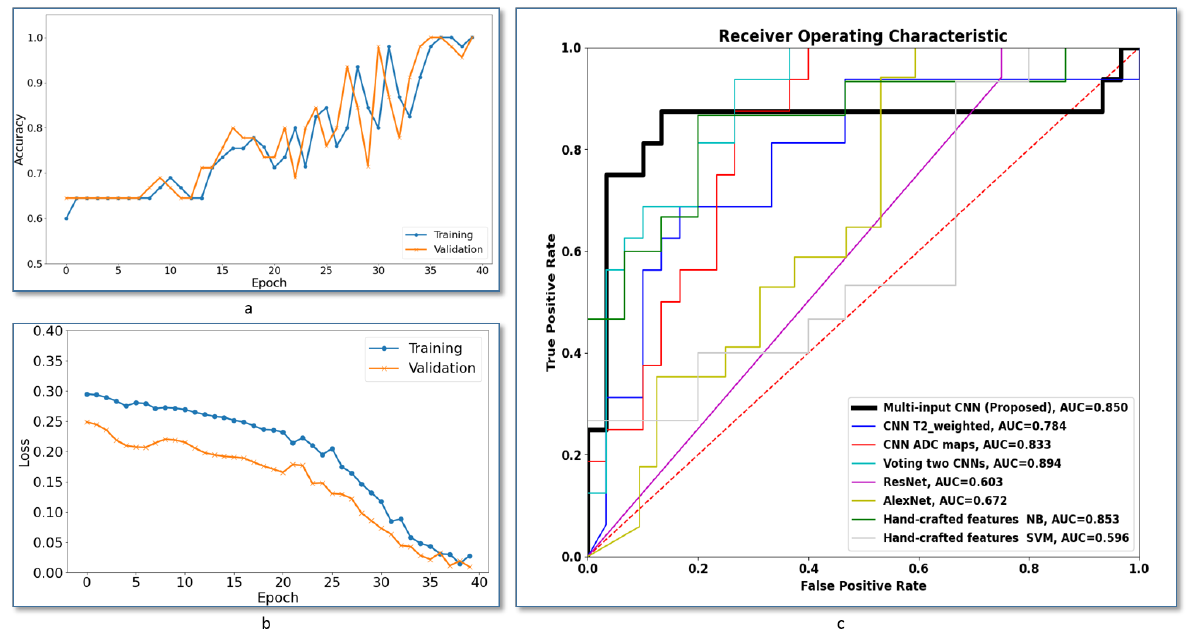
Figure 4. ( a ) Training versus validation accuracy curves with the number of epochs during network training. ( b ) Training versus validation loss curves with the number of epochs during network training. ( c ) Receiver operating characteristic curves (ROCs) of the proposed multi-input CNN framework compared to other methods. AUC is the area under the curve.“DT”—Decision Tree. “RF”—random forest; “NB”—Naive Bayes; “SVM”—support vector